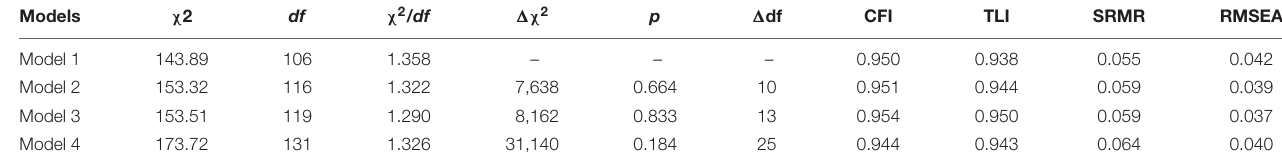
TABLE 5 | Multi-group Analysis of Gender